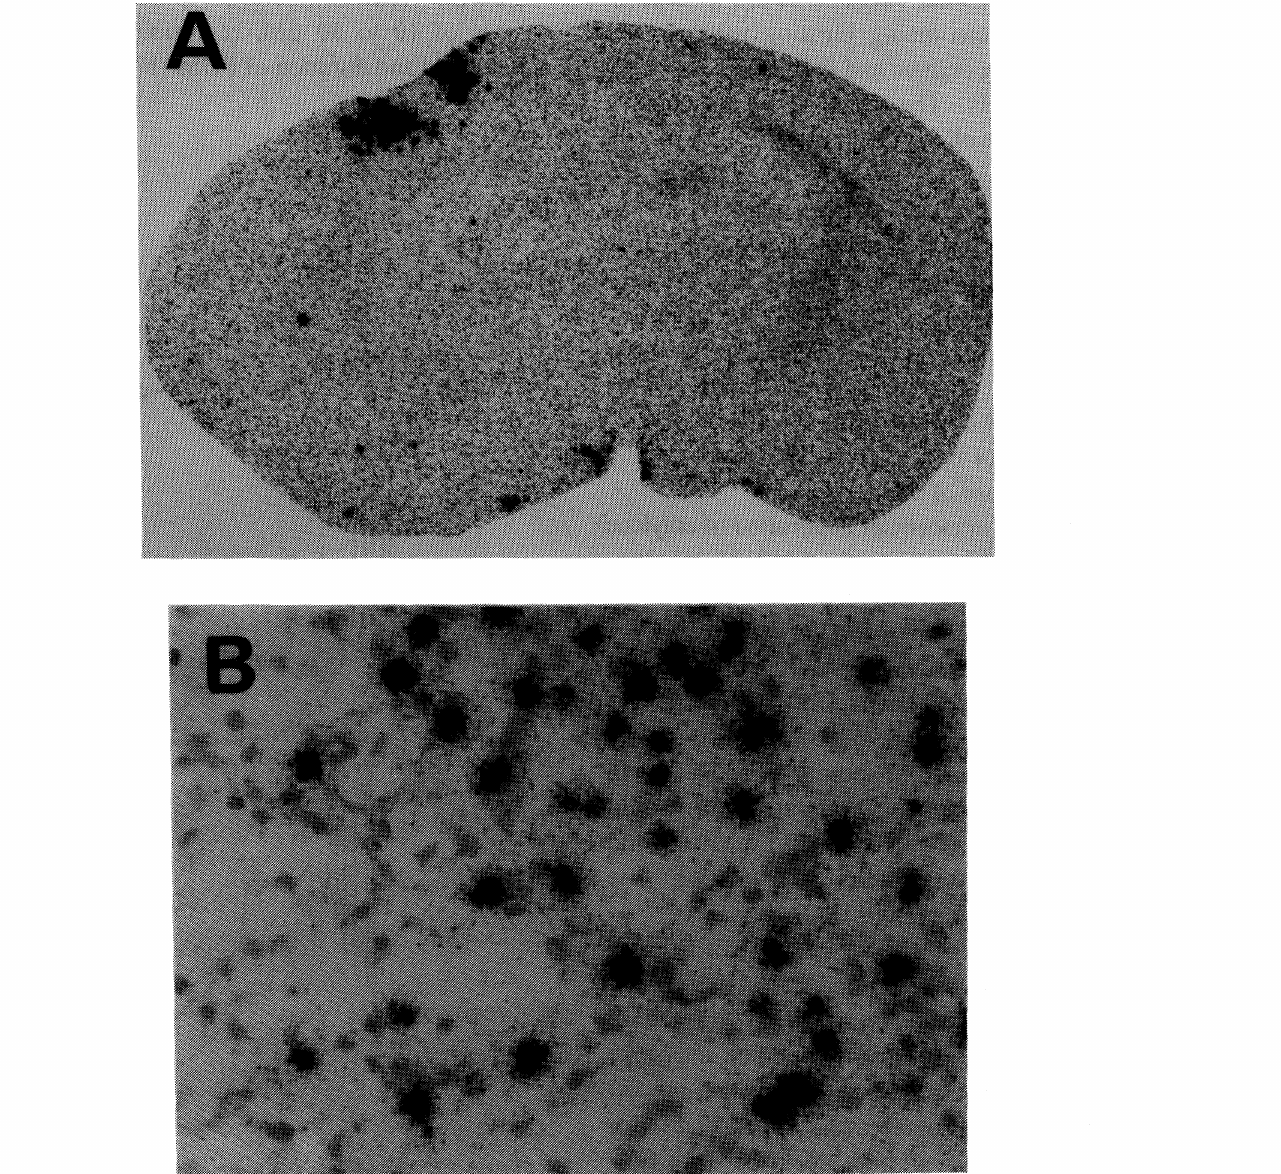
Fig. 4: Overexpression of tyrosine hydroxylase mRNAs revealed by in situ hybridization in the epileptic focus zone of a rat presenting GABA-withdrawal syndrome. A: densitometric figure of a brain slice labeled with a radioactive tyrosine hydroxylase-specific oligonucleotide. B: Magnified photomicrograph (x250) of the labeled zone, showing neurones with high density of silver